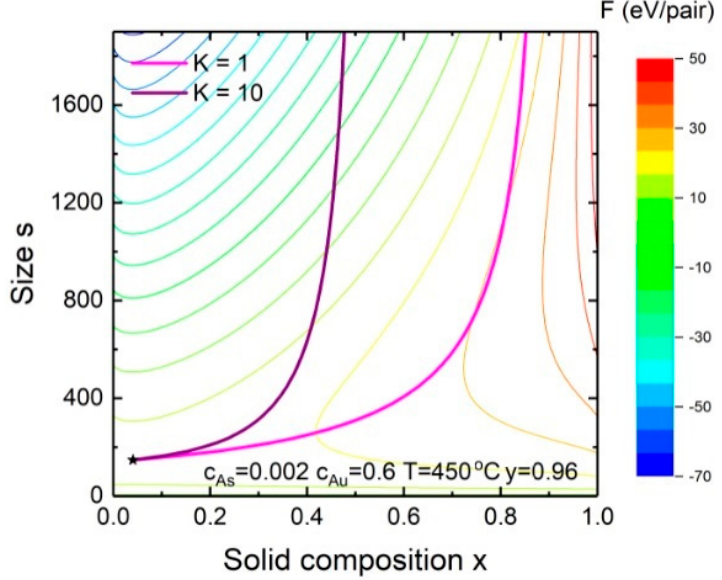
Figure 4. Evolution of the solid composition with nucleus size for In x Ga 1- x As NWs at 𝑦 = 0.96 . The solid thin lines correspond to the levels of the formation energy, F.